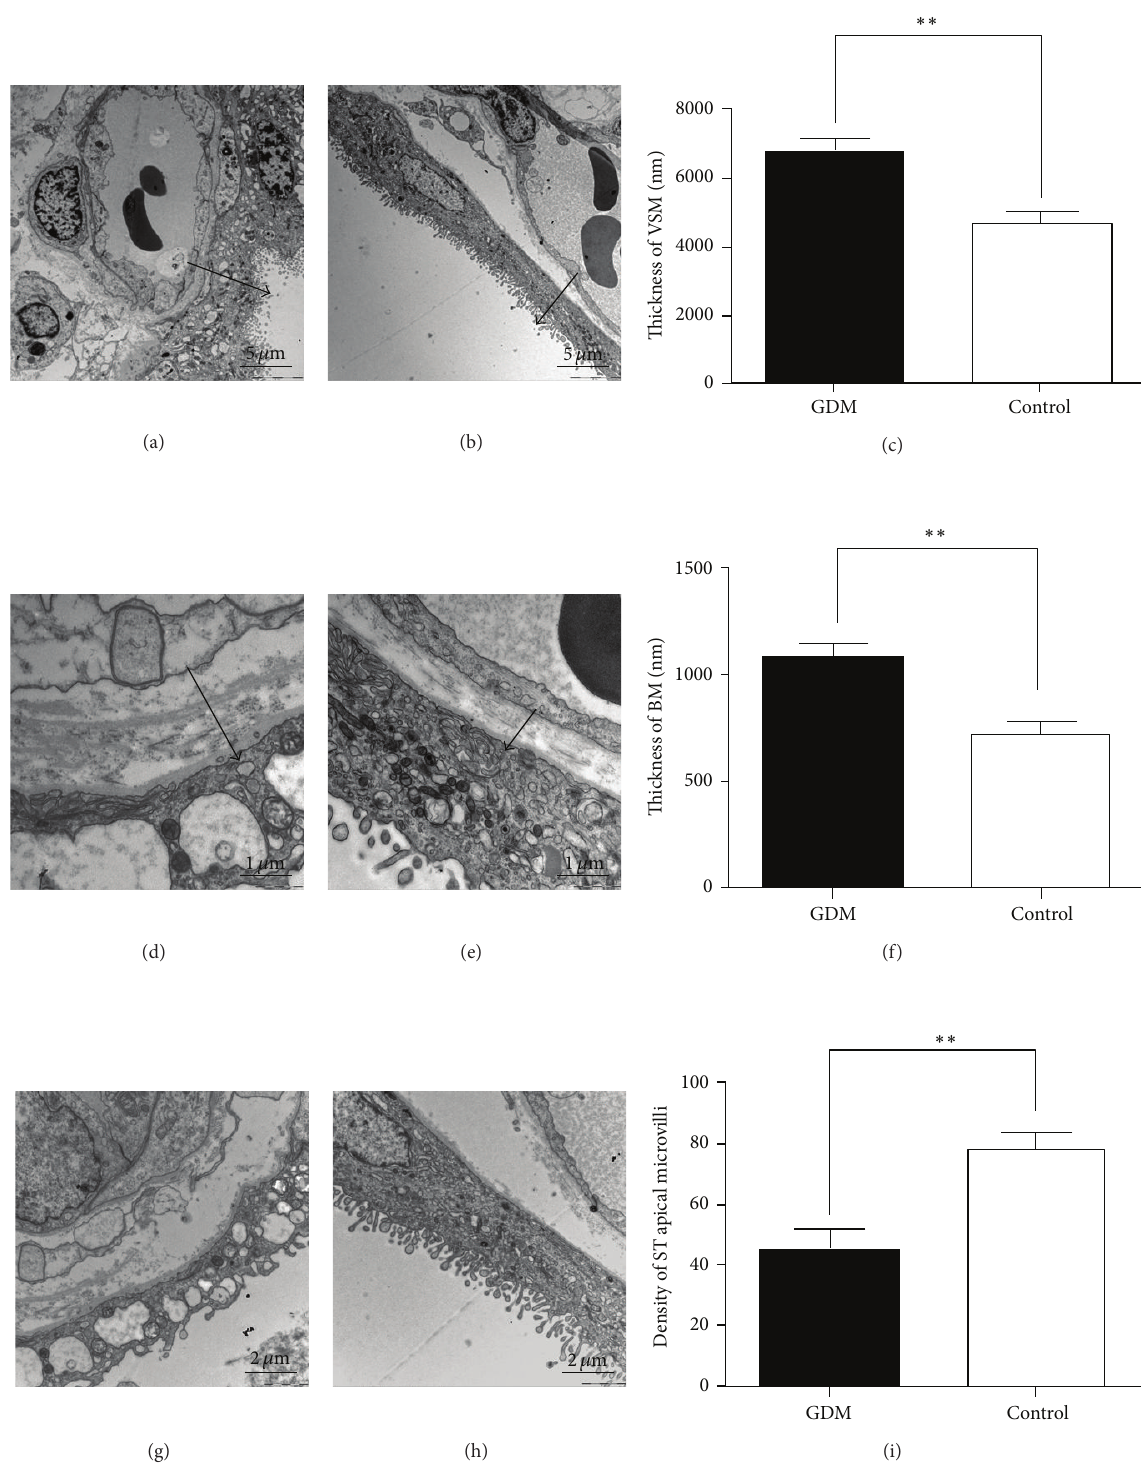
Figure 3: Comparison of semiquantitative parameters of placental ultrastructures between GDM and control group. (a–c) The terminal villi of GDM (a) and control (b) placenta. (c) Placental barrier thickness (arrow) of GDM group ( 6746.15 ± 1270.22 nm, 𝑛 = 10 ) was significantly thicker than that of control group ( 4591.34 ± 1178.60 nm, 𝑛 = 10 ; 𝑃 < 0.05 ). Bar = 5um. (d–f) The terminal villi of GDM (d) and control (e) placenta. (f) The BM of ST in GDM group ( 1077.49 ± 194.39 nm nm, 𝑛 = 10 ) was thicker than that in control group ( 707.54 ± 256.56 nm, 𝑛 = 10 ; 𝑃 < 0.05 ). Bar = 1um. (g–i) The density of ST apical microvilli in GDM (g) and control (h) placenta. (i) The density of ST apical microvilli in GDM group ( 44.36±21.95 per 10 um, 𝑛 = 10 ) was significantly lower than that in control group ( 77.13±20.82 per 10um, 𝑛 = 10 ; 𝑃 < 0.05 ) and even microvilli-free in some areas. Bar = 2